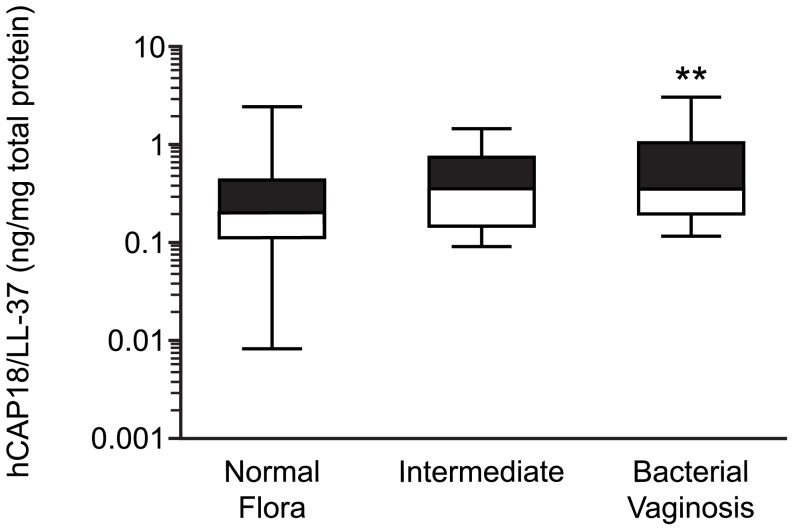
hCAP18/LL-37 expression in cervicovaginal secretions of women with and without Bacterial Vaginosis.hCAP18/LL-37 concentration in women with normal flora, intermediate vaginal flora and bacterial vaginosis. Data presented as median ± interquartile range. **, p<0.01 (One-way ANOVA with Dunnett's post-test) compared to those with normal flora.